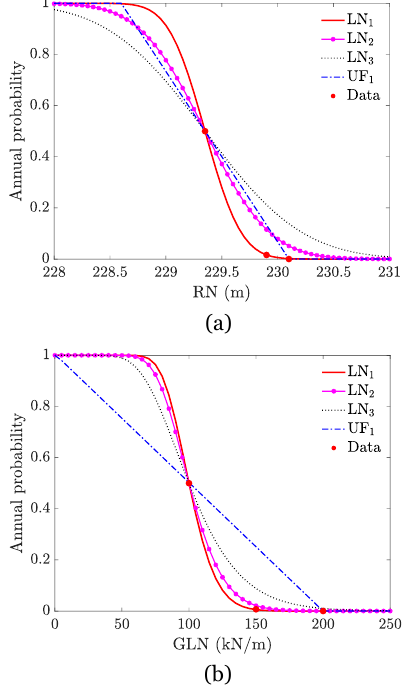
Figure 6. Annual probability of exceedance: ( a ) RN and ( b ) GLN. Figure 6a,b are combined to define the LCs by generating joint cumulative distribution functions, as shown in Table 5. Then, the joint cumulative distributions are intersected with horizontal constant probability planes equal to the annual probabilities defined in Table